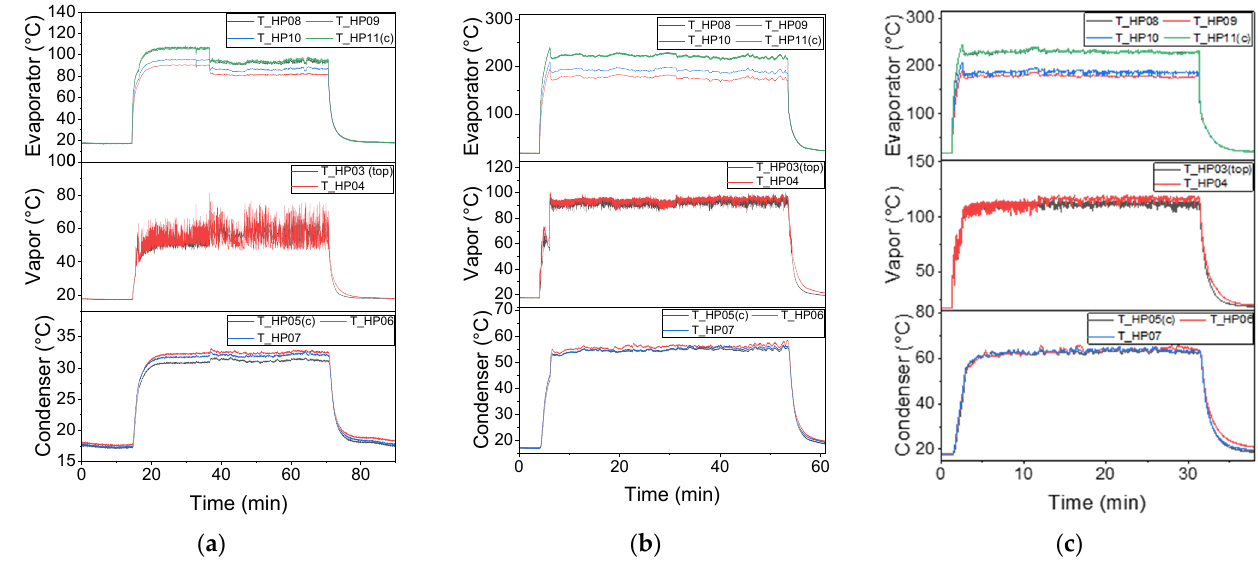
Figure 14 . Mock-up-1 temperature evolution with liquid inventory for 1 MW/m 2 and laser calori- metric power: ( a ) 150 W (heat flux: 0.3 MW/m 2 ); ( b ) 400 W (heat flux: 0.82 MW/m 2 ); ( c ) 500 W (heat flux: 1.0 MW/m 2 ).